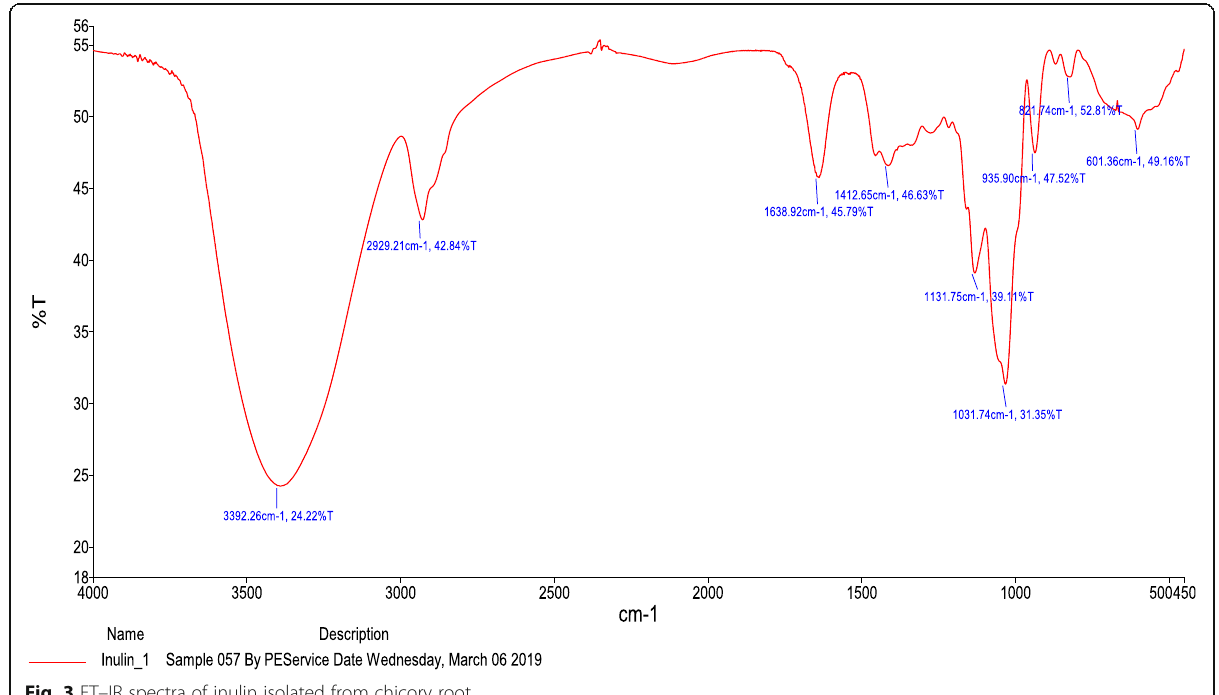
Fig. 3 FT – IR spectra of inulin isolated from chicory root